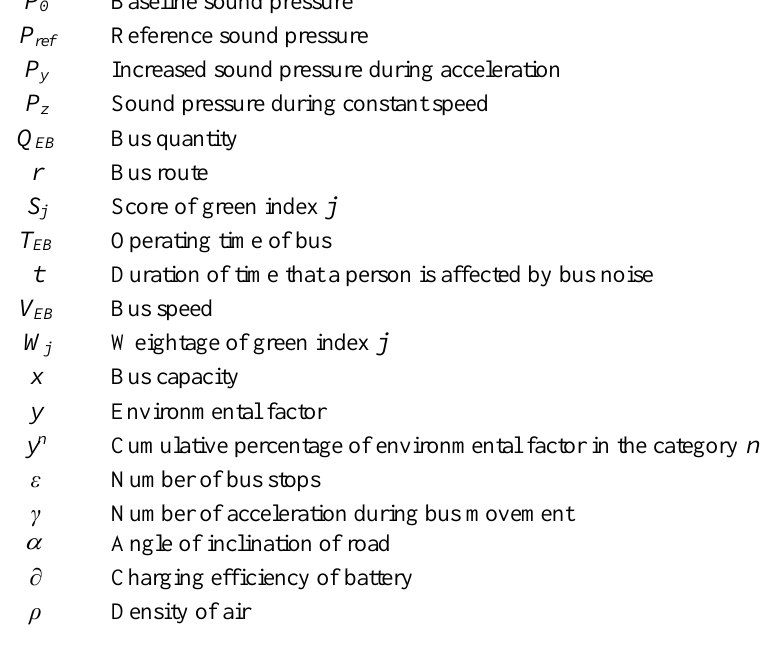
Environmental Factor, y 1 ,y 2